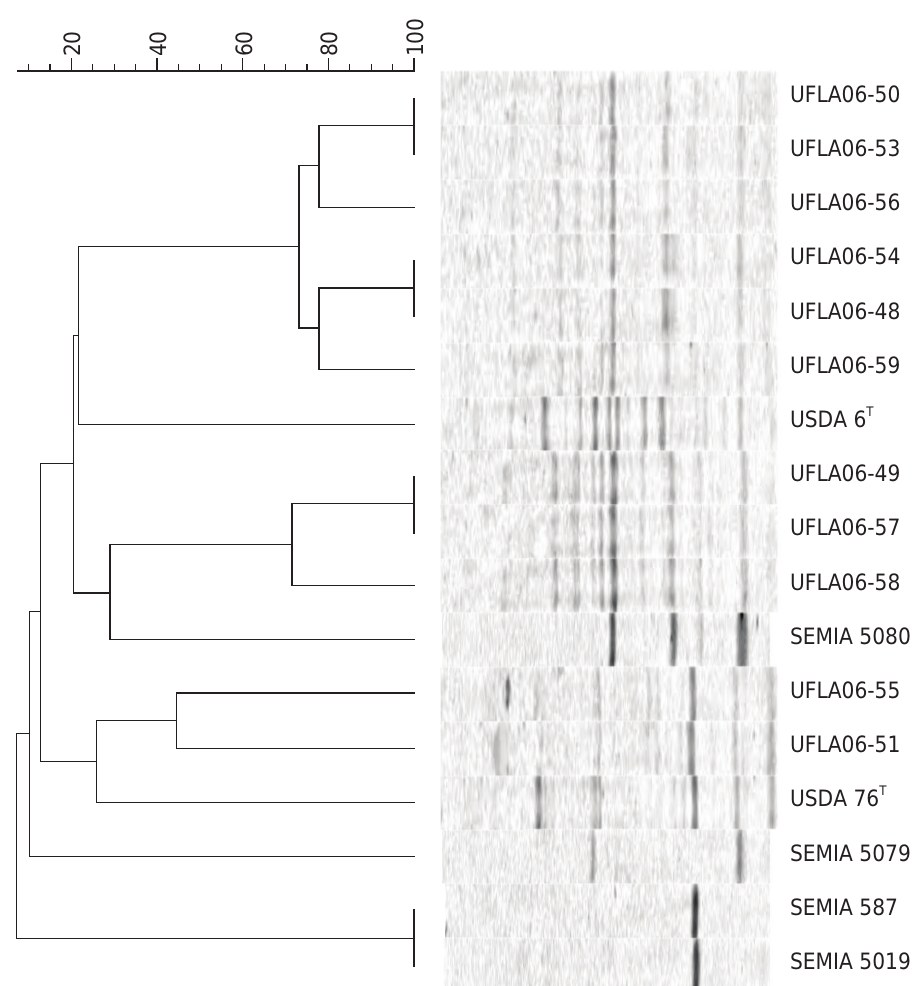
Figure 2. Dendrogram obtained by comparison of profiles obtained by the BOX-PCR technique of the isolates of commercial inoculants, of the type strains of these species, and of the strains approved as inoculants to